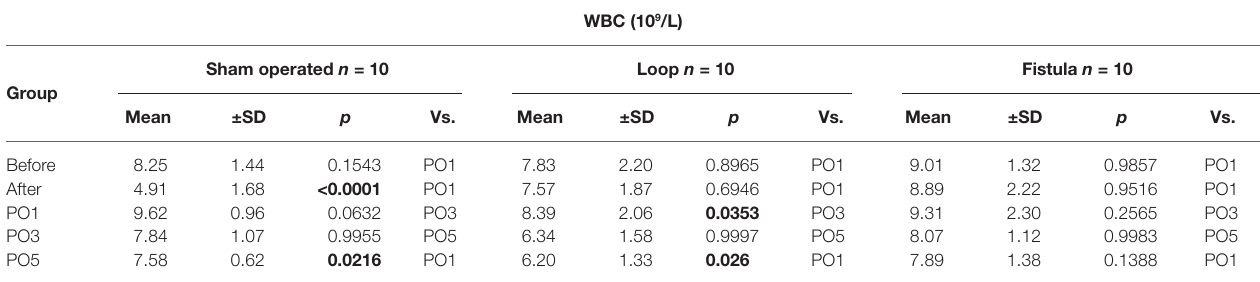
The bold means that the p values are at significant